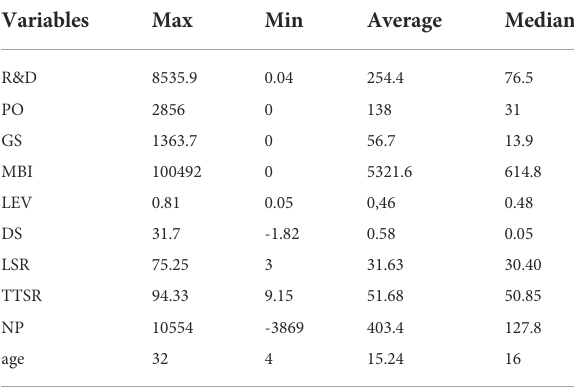
TABLE 2 Descriptive statistics before